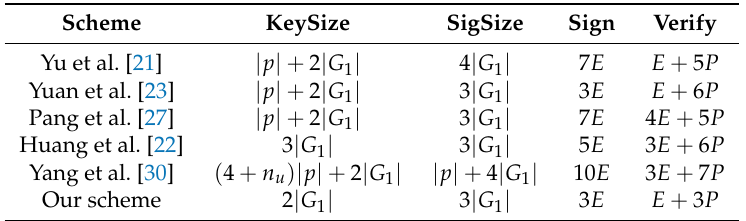
Table 1. A comparison of the CLS scheme performance.